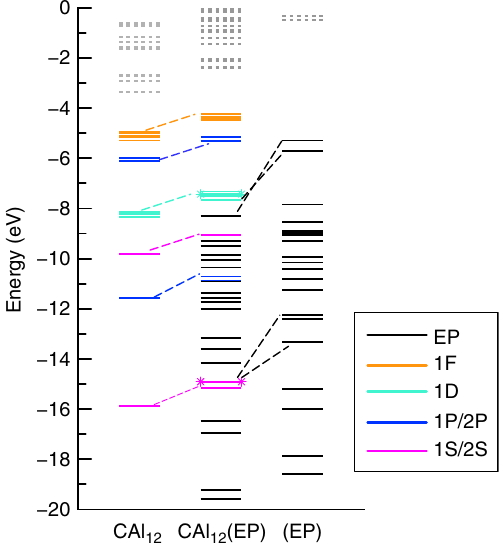
12 (EP) with CAl 12 and EP fragments. The occupied and unoccupied states are represented by solid and dashed